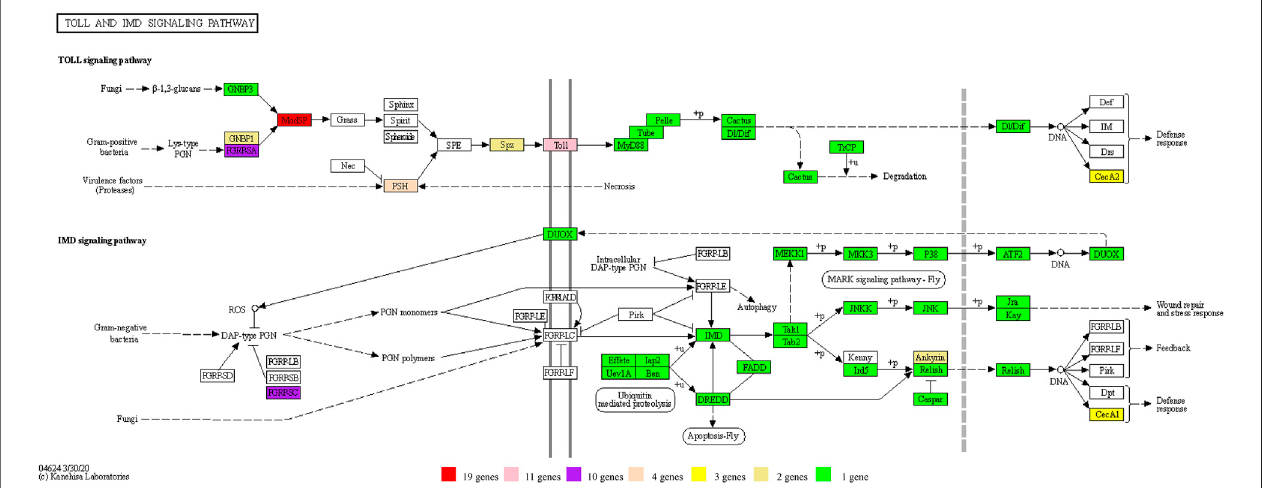
FIGURE7| ThegenesoftheTollandIMDsignalingpathwaysidenti fi edintheD.kikuchiigenome.ThegenenumbersforthecorrespondingKOareindicatedbythe color footnotes.